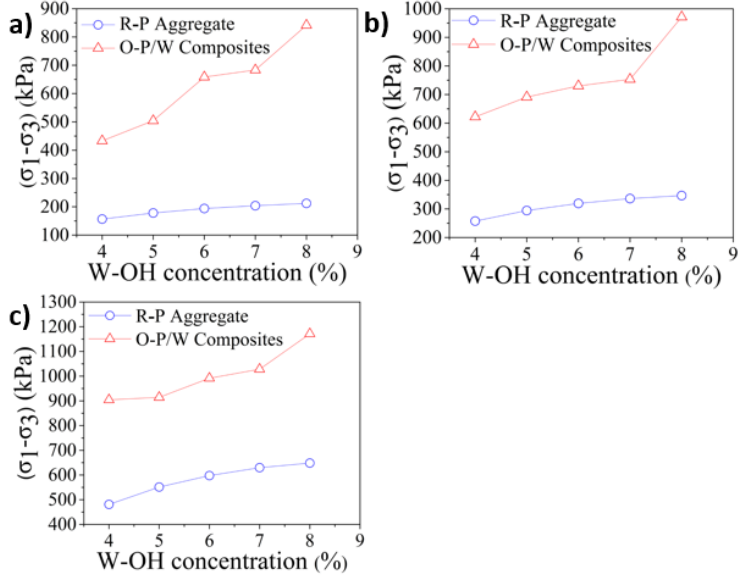
Figure 7. Deviator stress-axial strain curves of original Pisha/W-OH composites during triaxle compressive tests.